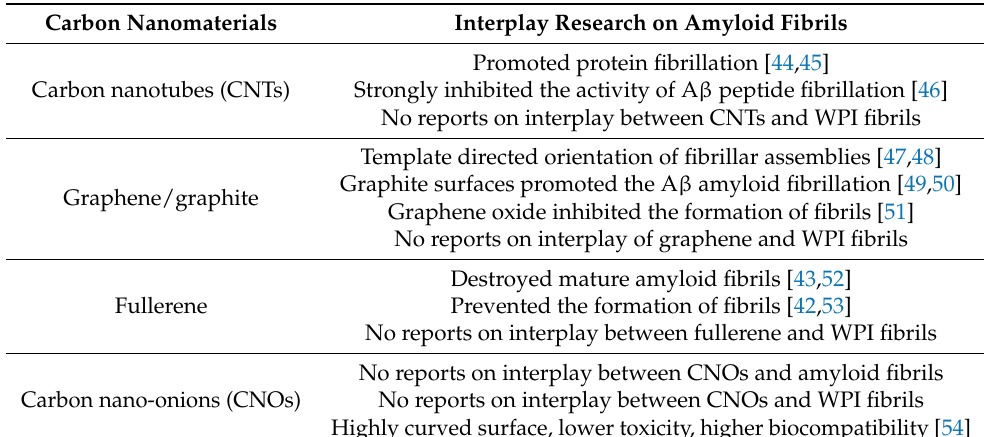
Table 1. Brief summary of the interplay between carbon nanomaterials and amyloid